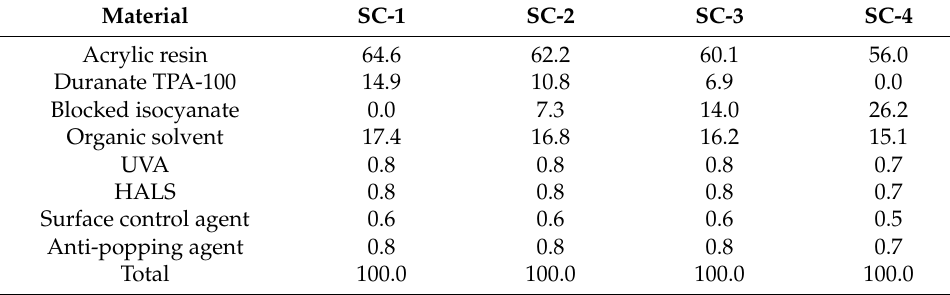
Table 5. Formulation of solventborne clearcoats